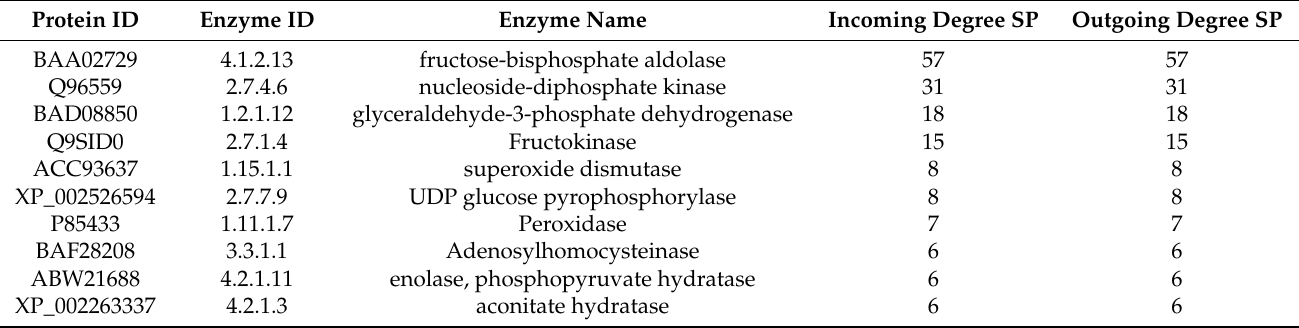
Table 6. Analysis of top 10 choke points for enzymes based on the metabolic pathways of Gossypium arboretum